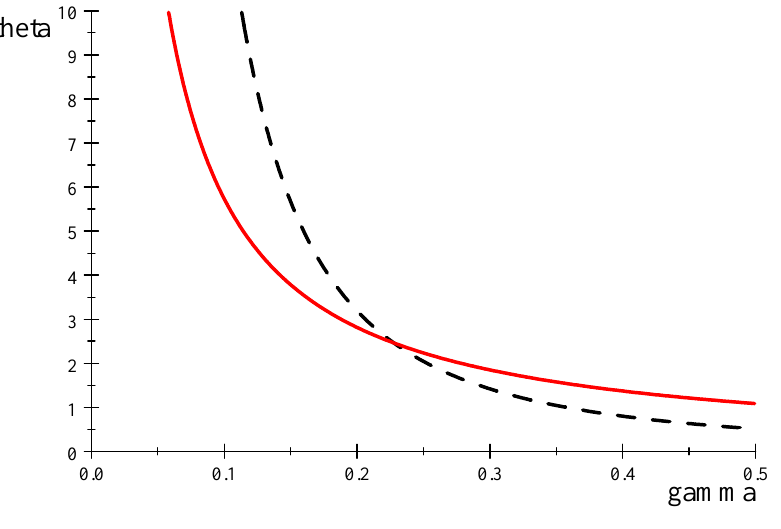
Figure 8: Changes of labour market tightness with respect to vacancy posting cost: